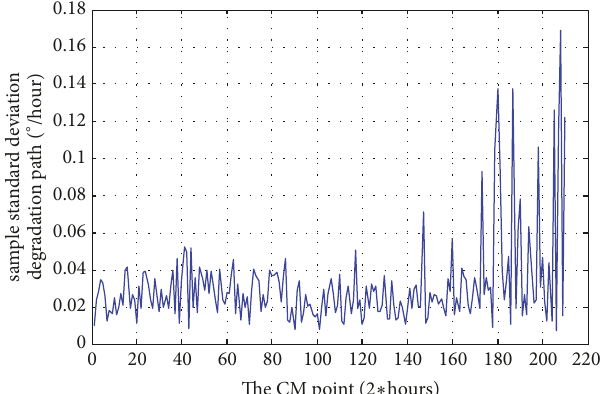
Figure 7: The fluctuation items.